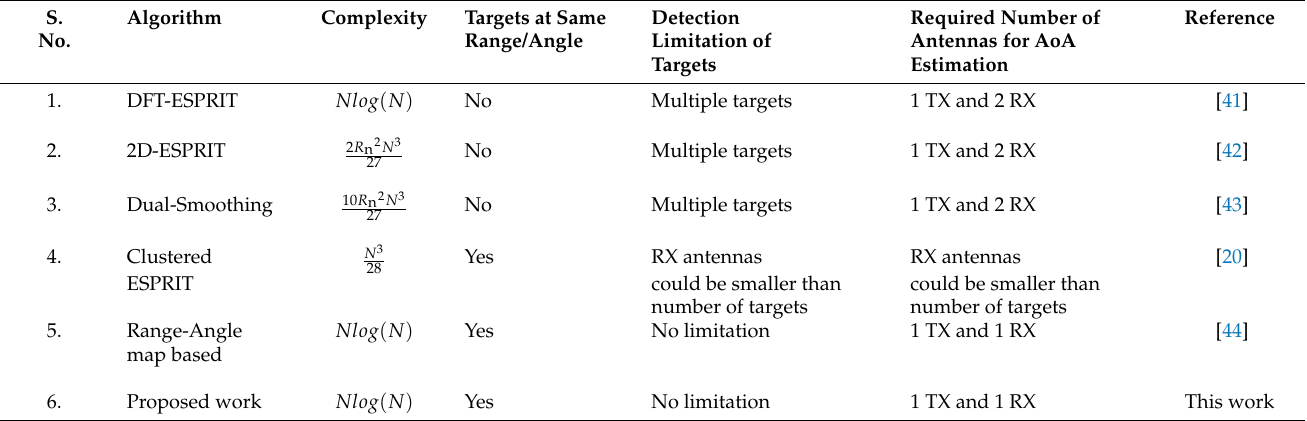
Table 4. Performance comparison table a